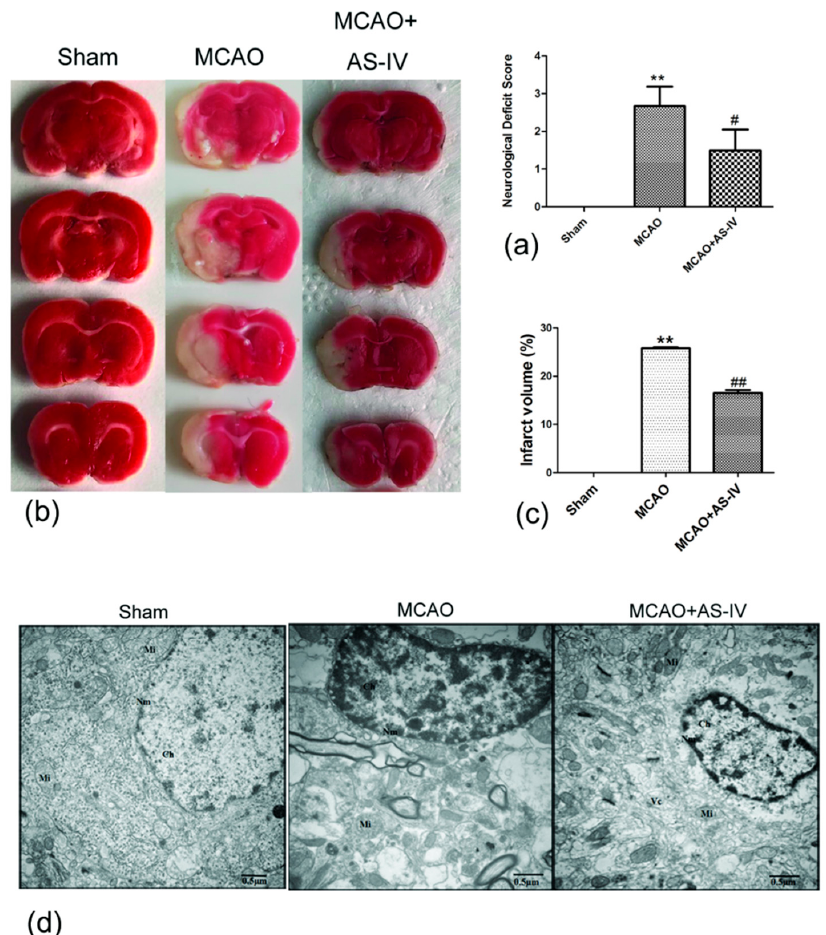
Figure 3. Neuroprotective effect of Astragaloside IV in rats after middle cerebral artery occlusion method (MCAO). ( a ) The neurological scores of rats (measured at 24 h after MCAO) (means ± SD, n = 6, ** p < 0.01 vs. Sham, # p < 0.05 vs. MCAO); ( b , c ) representative 2,3,5-Triphe-nyltetrazolium chloride (TTC) stained serial coronal brain sections (measured at 24 h after MCAO) (means ± SD, n = 3, ** p < 0.01 vs. sham, ## p < 0.01 vs. MCAO); ( d ) observation of ultrastructure of neurons by transmission electron microscope. (scale bar = 0.5 µm); Nm: Nuclear membrane; Ch: Chromatin; Mi: Mitochondria;